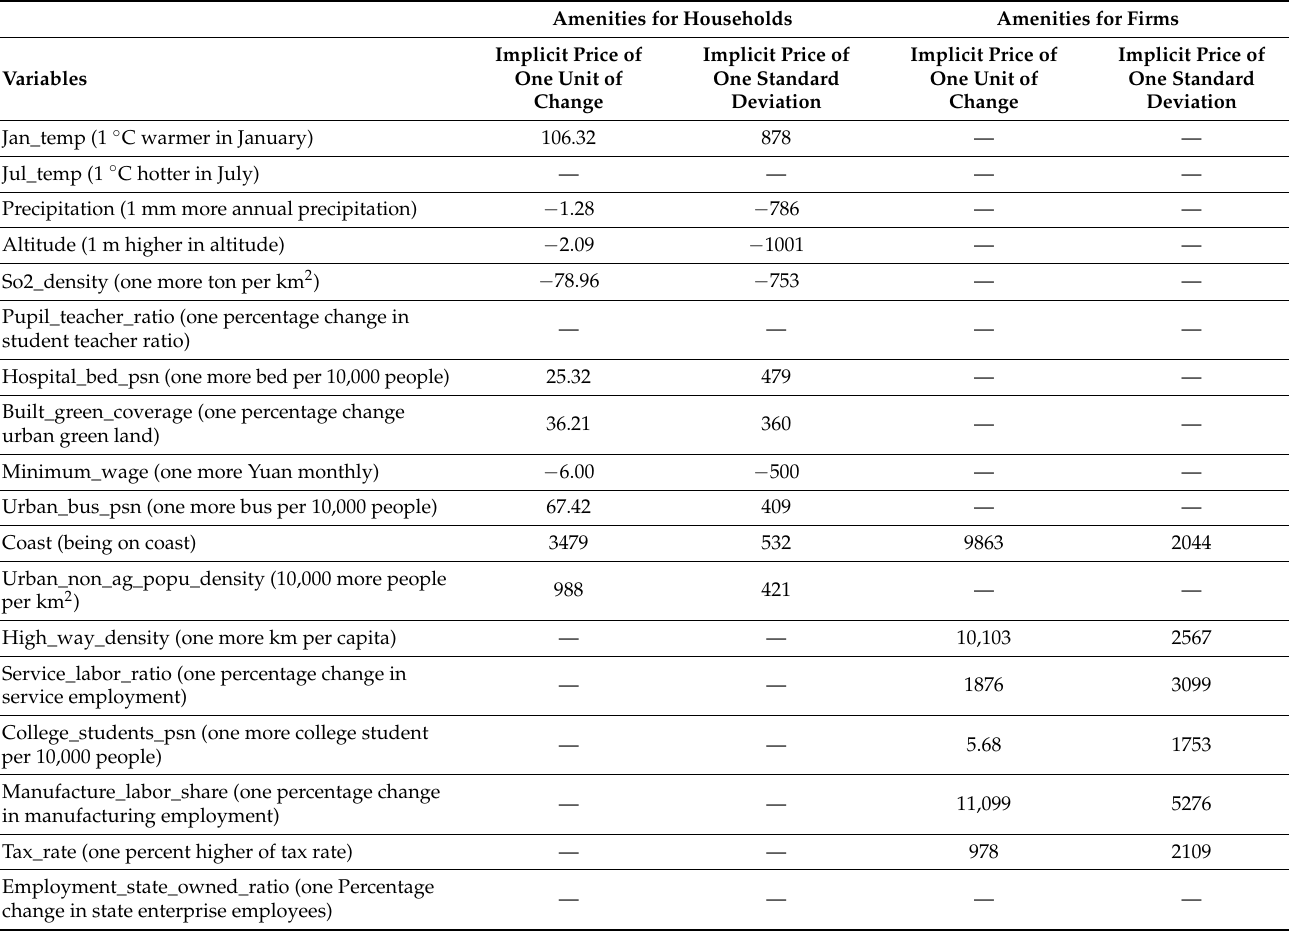
Table 3. Implicit prices of amenities for both households and firms. Amenities for Households Amenities for Firms Implicit Price of Implicit Price of Implicit Price of One Unit of One Standard One Unit Change Deviation